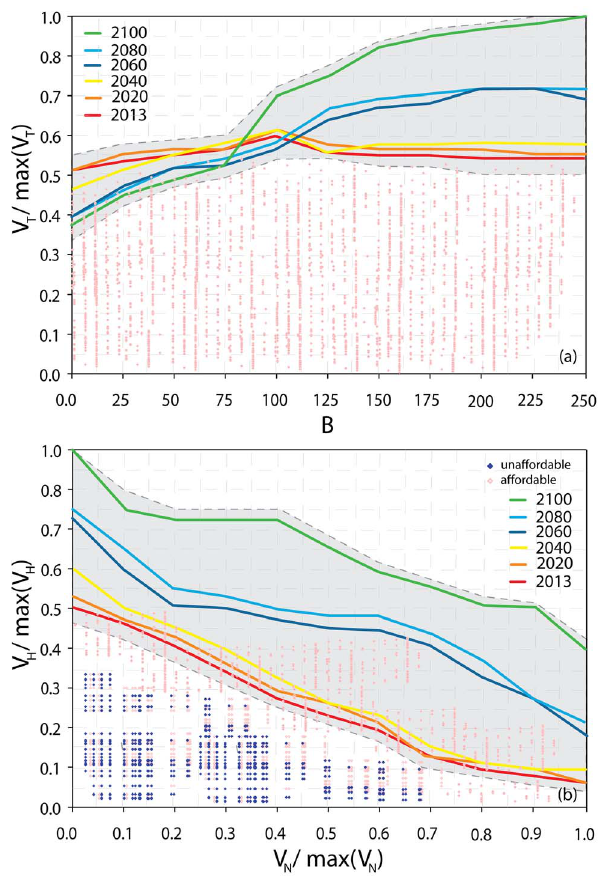
Figure 4. Pareto frontiers after realization of the selected restoration plan. (a) Pareto optimization unconstrained to the available resources. Red points represent the suboptimal restoration plans for the frontier in 2013. Grey dashed lines represent the variability of the frontiers related to thirty Monte Carlo simulations generated considering a random white noise applied to the MCDA value. (b) Pareto frontiers constrained to the resources available for selected years of analysis; we assume that the total resources available are equal to 250 at the installation scale (Eglin AFB in Figure 1). The frontiers show V H and V N (Eq. 2) normalized to their maximum value. The blue and red dots represent unaffordable and affordable restoration plans (or portfolios) for 2100. All the possible values of V H (R) and V N (R) for selected years are shown along the Pareto frontiers. The choice of the Pareto set depends on relative stakeholder preferences for human and natural